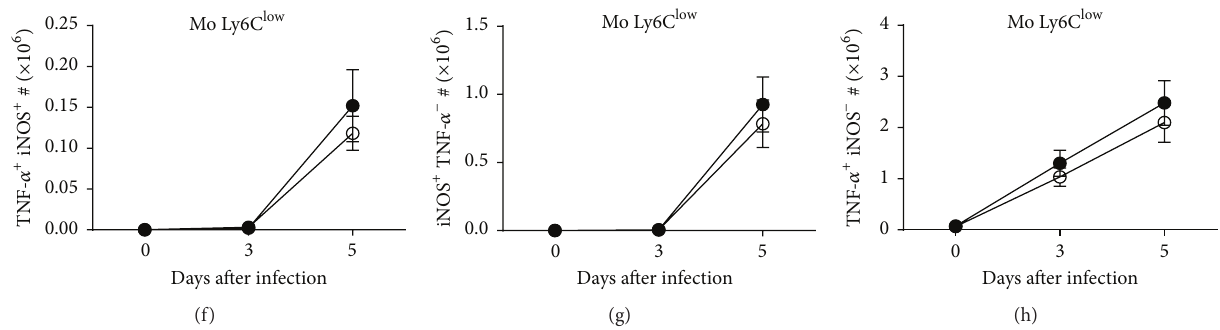
Figure 6: MIF promotes classical activation (M1) of inflammatory Ly 6 C high monocytes. Monocytes (Ly 6 C high and Ly 6 C low ) from infected WT ( I ) and Mif −/− ( e ) mice were analyzed for iNOS and TNF- 𝛼 production at 0, 3, and 5 days after infection. (a) Representative dot plots from iNOS/TNF- 𝛼 -producing Ly 6 C high monocytes. (b) Absolute numbers of iNOS + TNF- 𝛼 + , (c) iNOS + TNF- 𝛼 − , and (d) TNF- 𝛼 + iNOS − cells from Ly 6 C high monocytes. (e) Representative dot plots from iNOS/TNF- 𝛼 -producing Ly 6 C low monocytes. (f) Absolute numbers of iNOS + TNF- 𝛼 + , (g) iNOS + TNF- 𝛼 − , and (h) TNF- 𝛼 + iNOS − cells from Ly 6 C low monocytes, during the acute phase of infection with T. gondii ( 𝑛 = 3 animals at each time point, representative of 2 independent experiments). Data are presented as the mean ± SE. ∗ 𝑃 < 0.05 ; ∗∗ 𝑃 < 0.01 . in line with a higher number of tachyzoites observed in the peritoneum of Mif −/− compared with WT mice at days 5 and 7 after T. gondii infection (Figure